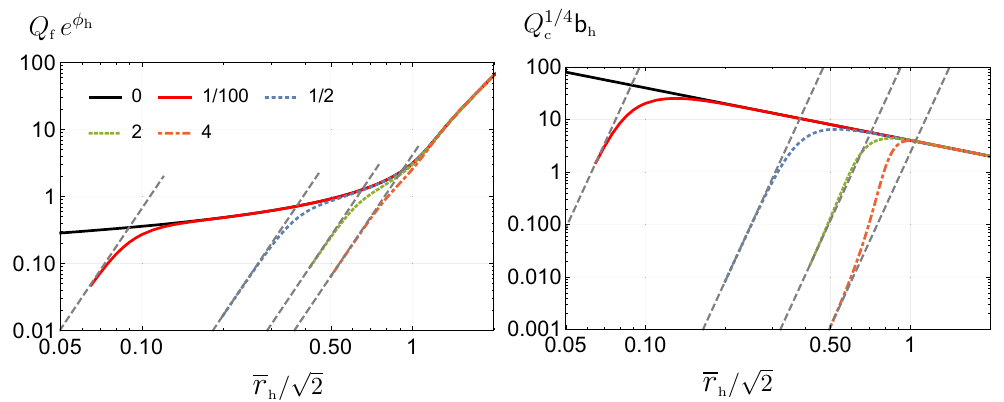
Figure 4 . IR coefficients φ legend of the plot on the left-hand side). The dotted gray lines show the behavior determined by the IR Lifshitz solution.